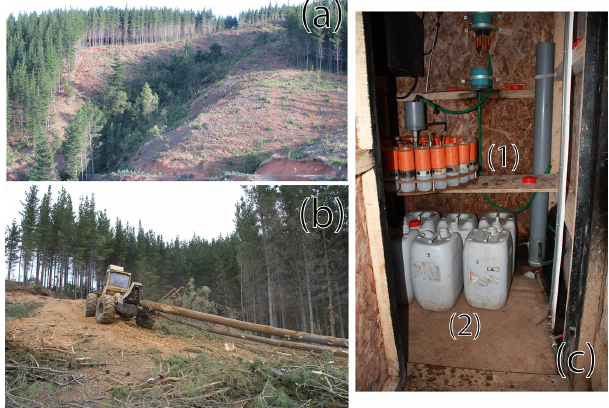
Figure 2. Pictures showing the experimental catchments, the log- ging procedure, and the suspended sediment monitoring devices. (a) Rainy season logged watershed (watershed 3) in the subsequent dry season (March 2010). (b) Skidder dragging logged stems uphill to the next landing in watershed 3. (c) Custom-built sediment sam- pling system: (1) horizontal rotating table used to sample suspended sediment per event and (2) recipient used to collect bulk sample of suspended sediment on weekly basis.